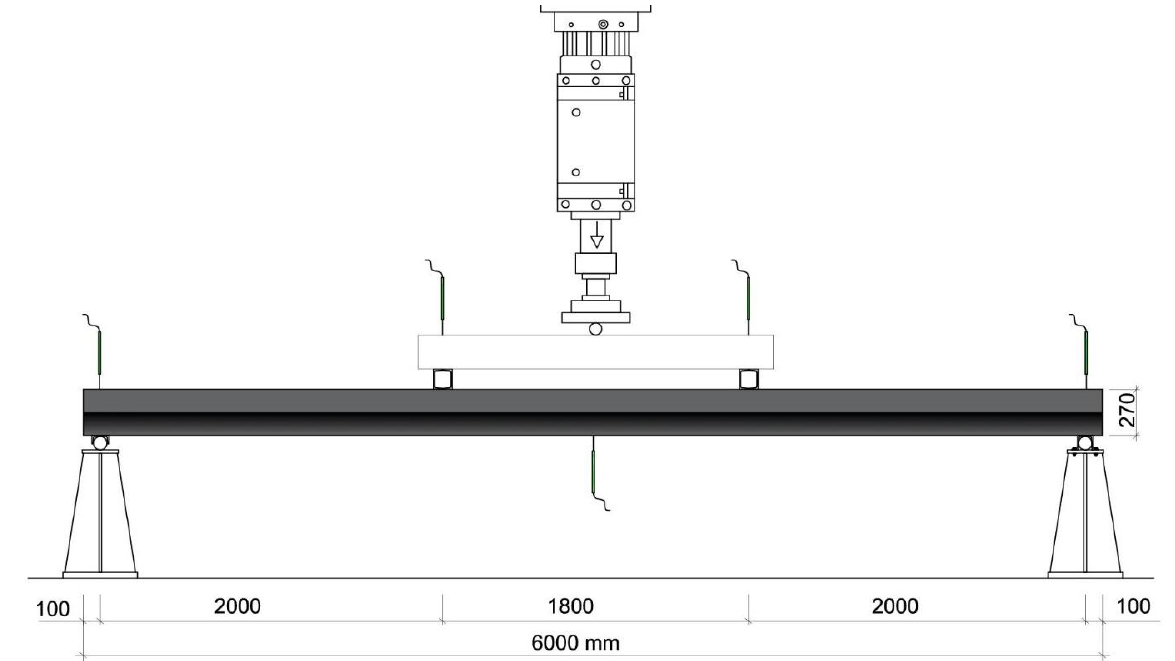
Fig. 4. Static scheme of composite beam and layout of